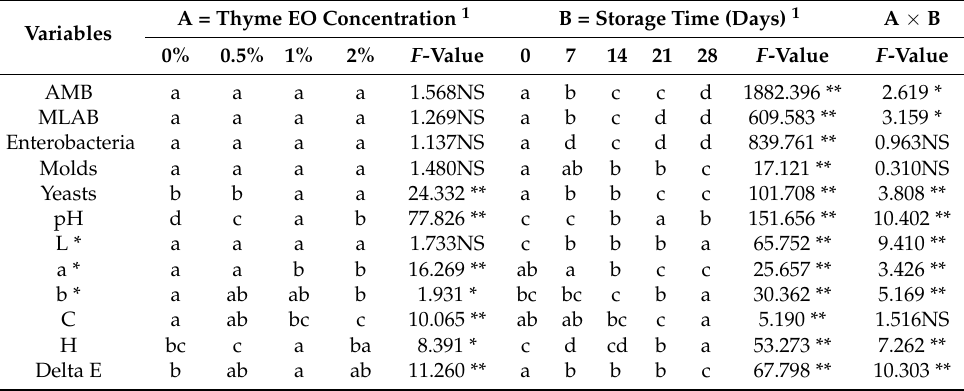
Table 2. Effect of (A) thyme EO concentration (4 levels: 0%, 0.5%, 1% and 2%) and (B) storage time (5 levels: 0, 7, 14 and 28 days) on microbial counts. pH and color parameters in RTE meat packaged during refrigerated